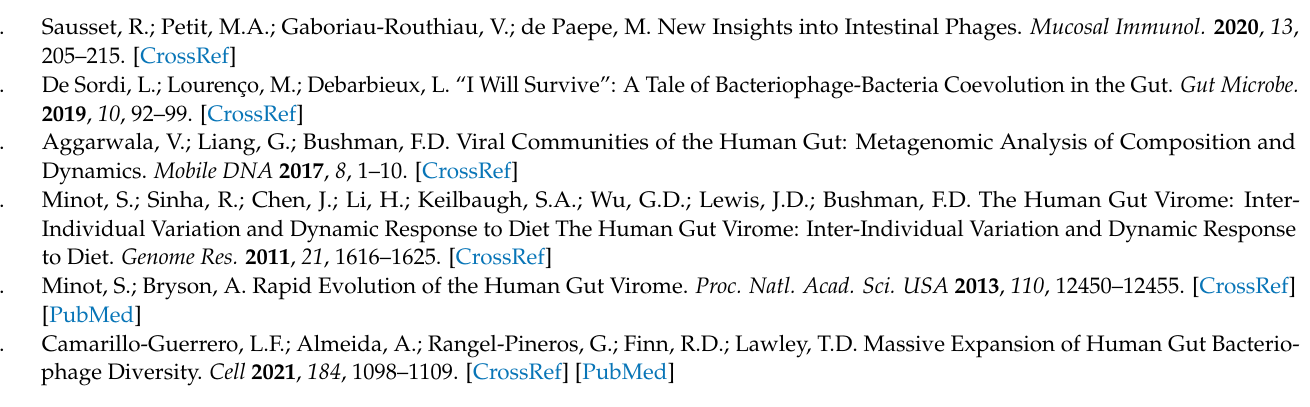
Table S4: Genetic differences in genes of Bacuni host derivatives, Data sheet S1: Putative functions of ORFs in prophages, Data sheet S2: Abundance of reads aligning to Bacuni F1 in gut metagenomes, Figure S1: Schematic overview of lysogenic assay, Figure S2: Vcontact clusters, the phage F1 is named 3P11 and the phage F4 8POS, Figure S3: Virfam server generated identification, Figure S4: Phylogenetic analysis of